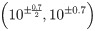
The 6 distinct filter shapes in (ν
ωL, ν
∞)-space.(c, f) Region 1–6 denote the regions exhibiting qualitatively similar filter shapes. E.g. spiking resonance is by definition region 1 and 2. Not all of these six regions are accessible for a given Q
L. Colored lines (blue to red) represent the Q
L-dependent boundary below which filter shapes are forbidden because of unstable dynamics. We note that ν
ωL, ν∞ → 0 = Q
L. An intrinsic frequency exists in region above the Q
L = 1/2 boundary. A voltage resonance exists in the region above the Q
L = 1 boundary. We show the accessible subset of corresponding filter shapes at representative positions within the regions (located at (10±0.72,10±0.7) and (10±0.7,10±0.72)) and at the border between regions (located at ν
ωL, ν
∞ = 10−1.5, 100, 101.5). (f) Same type of plot as (c), but for the phase response. π/2 and −π/2 are shown as top and bottom bounding dashed lines for the set of phase responses at each location. The gain and phase for the position denoted by the circle are shown in (a) and (c), and for the star in (b) and (e), respectively.